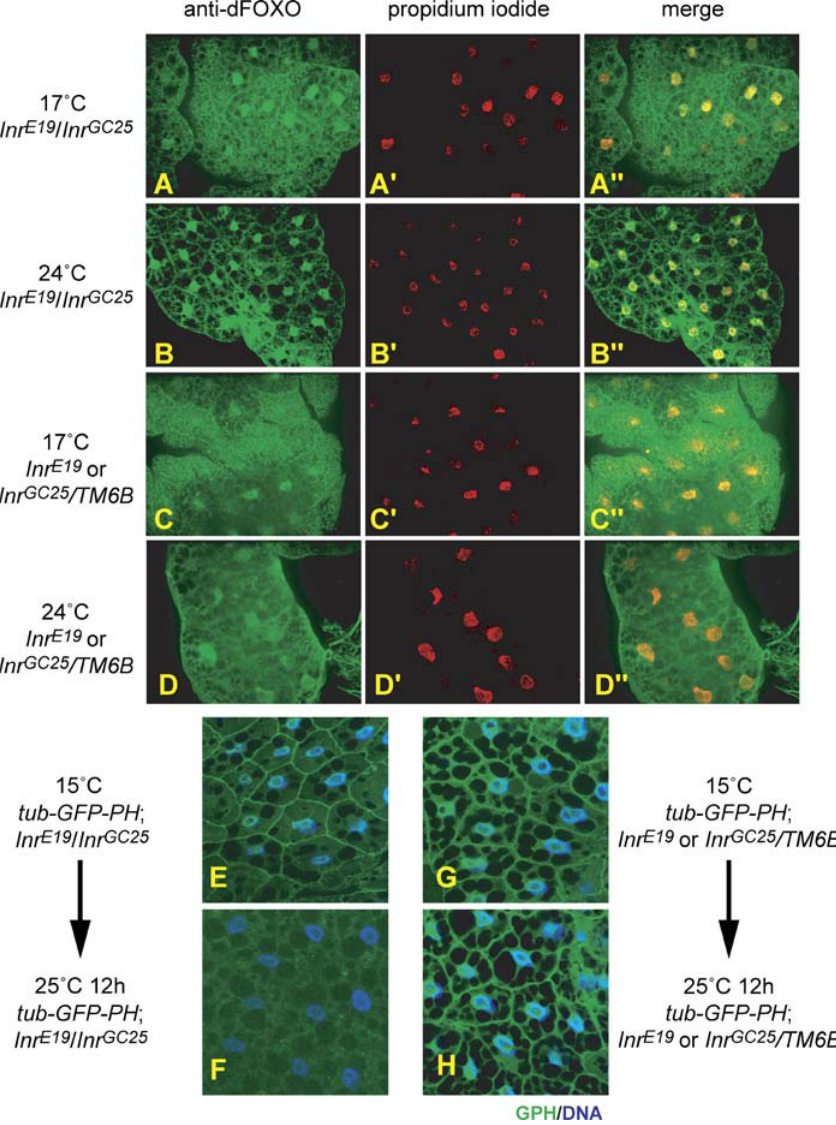
Figure 2. Increasing the Temperature of Inr E19 /Inr GC25 Flies Suppresses the Insulin-Signaling Pathway The dFOXO panel shows localization of dFOXO protein in the fat body, the propidium iodide panel shows the position of the nuclei, and the merge panel clarifies the degree of dFOXO localization to the nuclei. (A) Endogenous dFOXO in the fat body of Inr E19 /Inrv GC25 third instar larvae has weak nuclear localization at 17 8 C. (B) Increase in rearing temperature causes a decrease in cytoplasmic distribution and an increase in nuclear localization of dFOXO, consistent with a decrease in the level of insulin signaling (C and D) Temperature has no detectable effect on dFOXO localization in Inr E19 /TM3 control flies. (E) GPH membrane localization reveals high levels of insulin signaling in the fat body of Inr E19 /Inr GC25 second instar larvae reared at 15 8 C. GPH is in green, DNA is stained blue. (F) This localization is lost when the larvae are moved to 25 8 C for 12 h, consistent with a decrease in the level of insulin signaling. (G and H) Temperature has no detectable effect on GPH membrane localization in Inr E19 /TM3 control flies. DOI: 10.1371/journal.pbio.0030289.g002